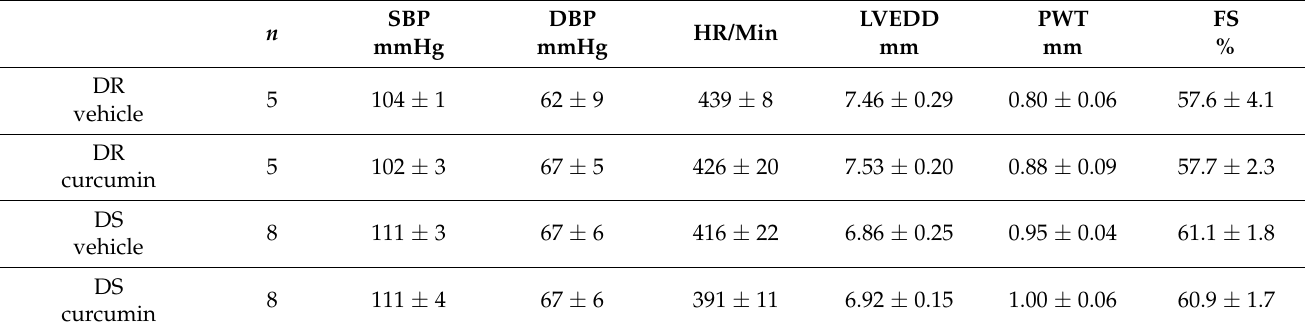
Table 1. Hemodynamic parameters in Dahl rats at 6-week-old.